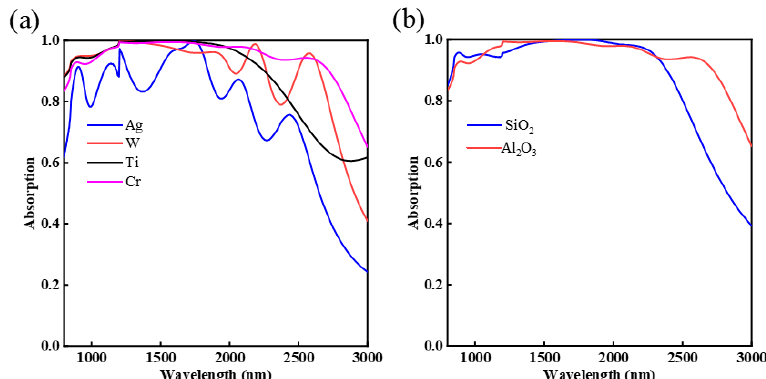
Figure 7. The influence of different materials on the absorption spectrum: ( a ) top metal materials; ( b ) dielectric layer.